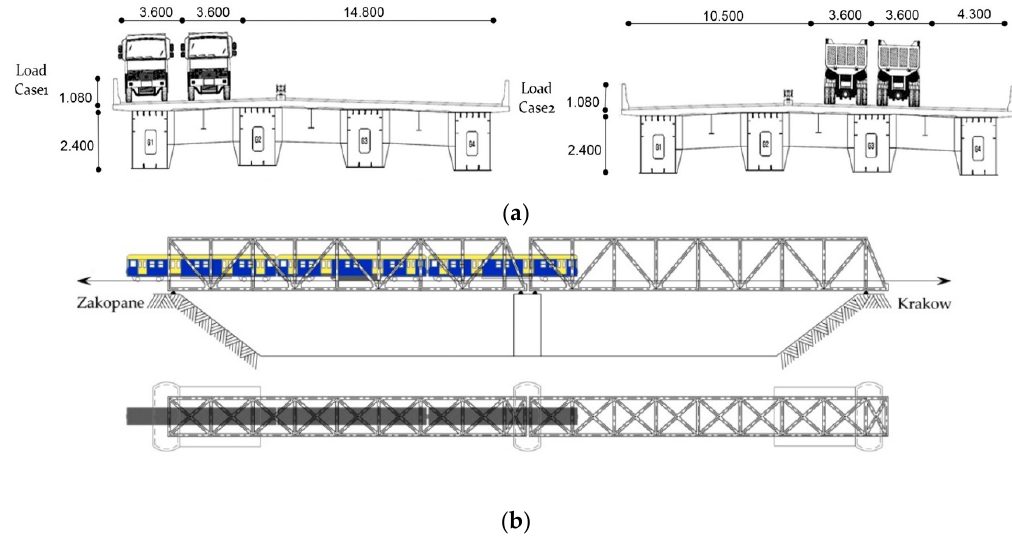
Figure 10. Static loading scenarios for deflection assessment: ( a ) static loading scenarios for girder bridge [136]; ( b ) static loading scenario for railway bridge [137]. Table 8. Examples of deflection measurement using TLS for different types of bridges.